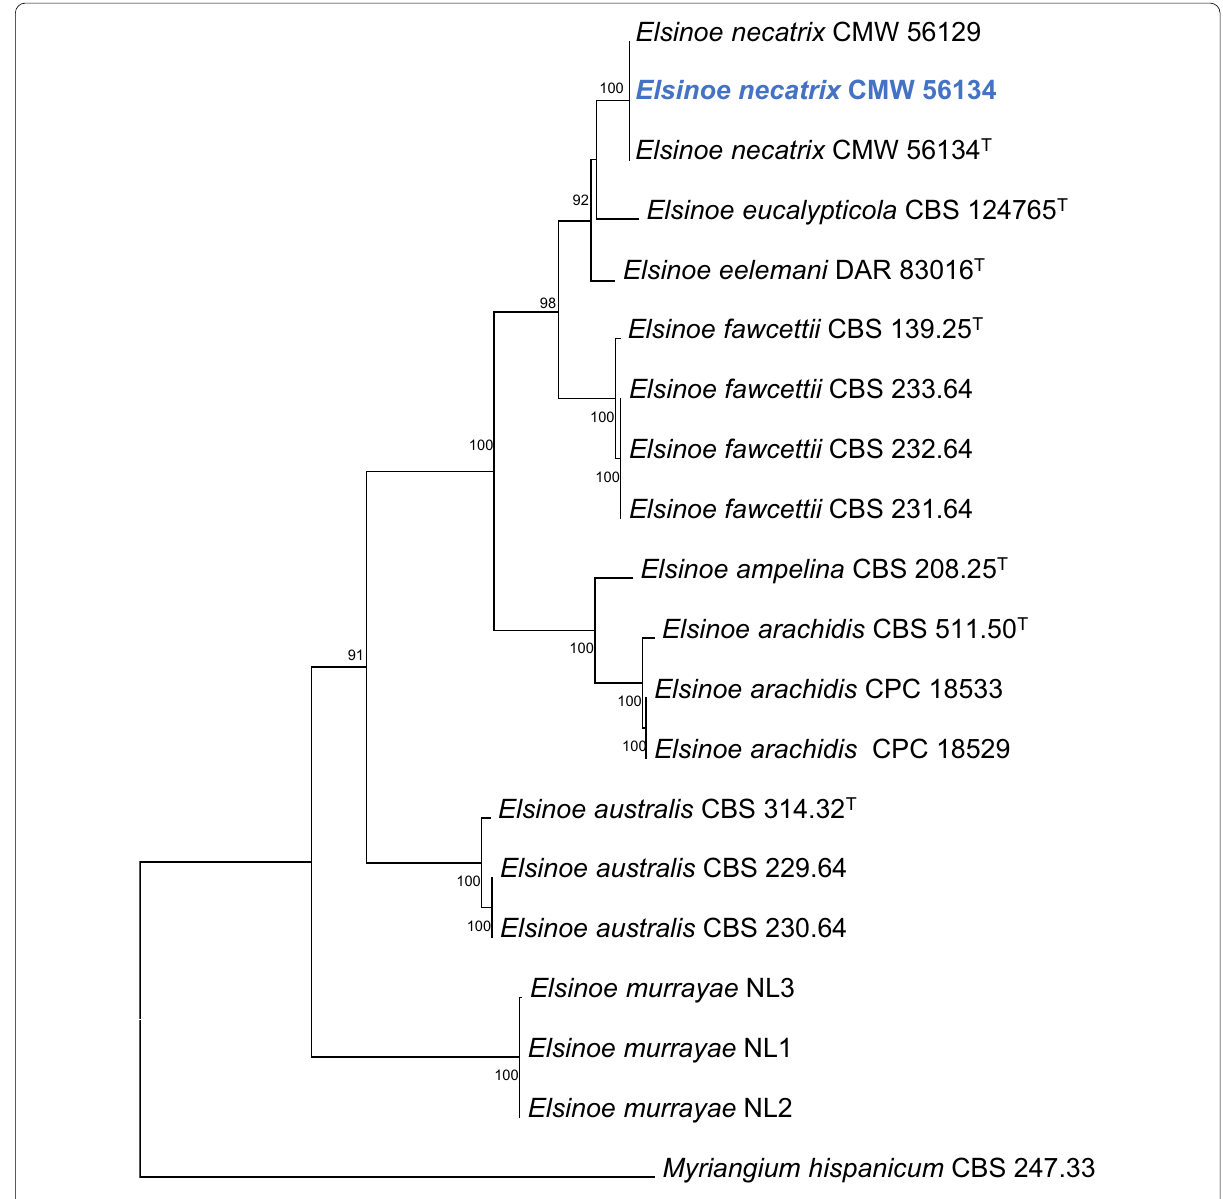
Fig. 5 Maximum Likelihood tree based on ITS, LSU, RPB2 and TEF1 sequences for Elsinoë spp. Bootstrap values at the nodes. Isolates representing ex‑type material are marked with “T”. Myriangium hispanicum (CBS 247.33) represents the outgroup. The genome sequenced in this study, of which the sequences were extracted from the assembly, is indicated in